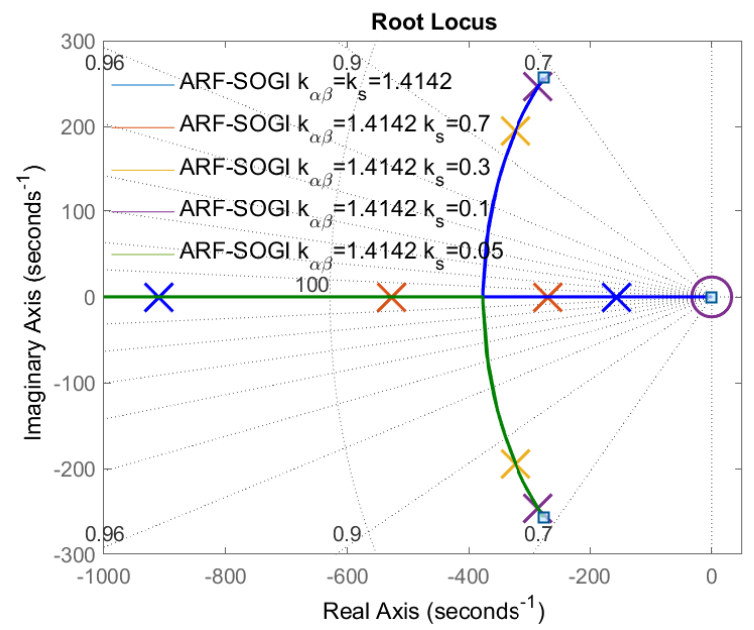
Figure 8. v (cid:48) ARF-SOGI-QSG